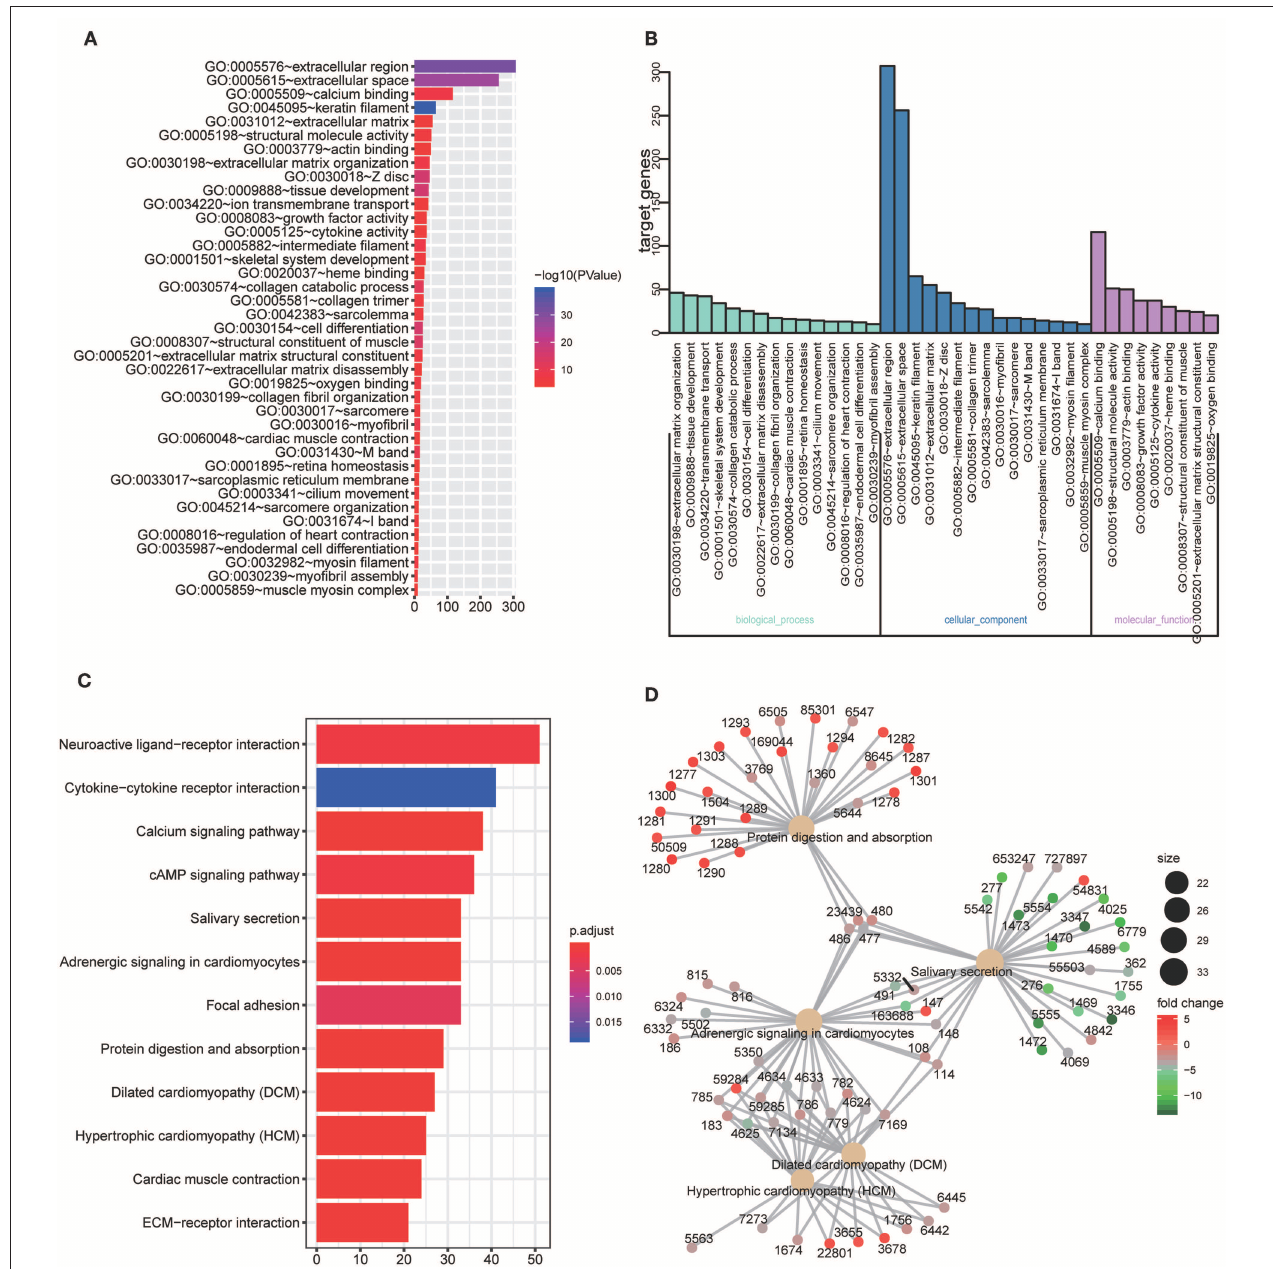
FIGURE 2 | GO and KEGG pathway analysis of DERNAs. (A) The numbers of genes enriched in each GO category. The y axis represents the GO categories including the biological process, cellular component and molecular function, and the x axis represents the enrichment score. Furthermore, the color stands for p -value. (B) GO analysis contains the biological process (BP, in green), cellular component (CC, in blue) and molecular function (MF, in purple). The y axis represents the target gene and the x axis represents the biological process. (C) The most important pathways in DERNAs. The y axis represents the pathways and the x axis represents enriched gene numbers, and the color means adjust P -value. (D) The Netplot of KEGG pathways, mean enrichment of genes in different pathways. The number adjacent to nodes stands for gene